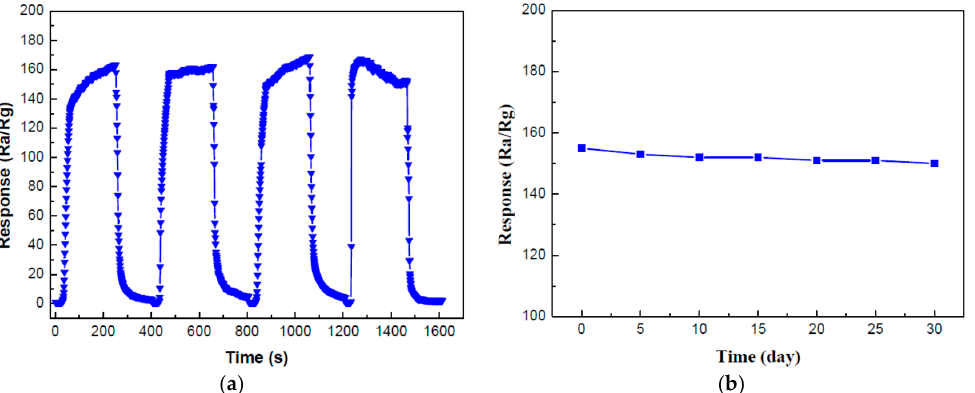
Figure 7. ( a ) Repeatability and ( b ) stability measurements of the SnO 2 /g-C 3 N 4 -7-based sensor to 500 ppm ethanol at 340 °C.